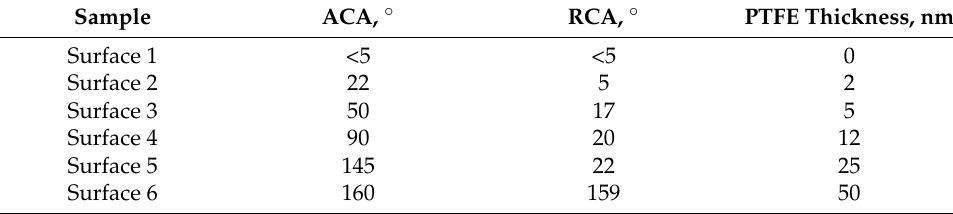
Table 1. Wettability of samples as a function of fluoropolymer layer thickness (PTFE).